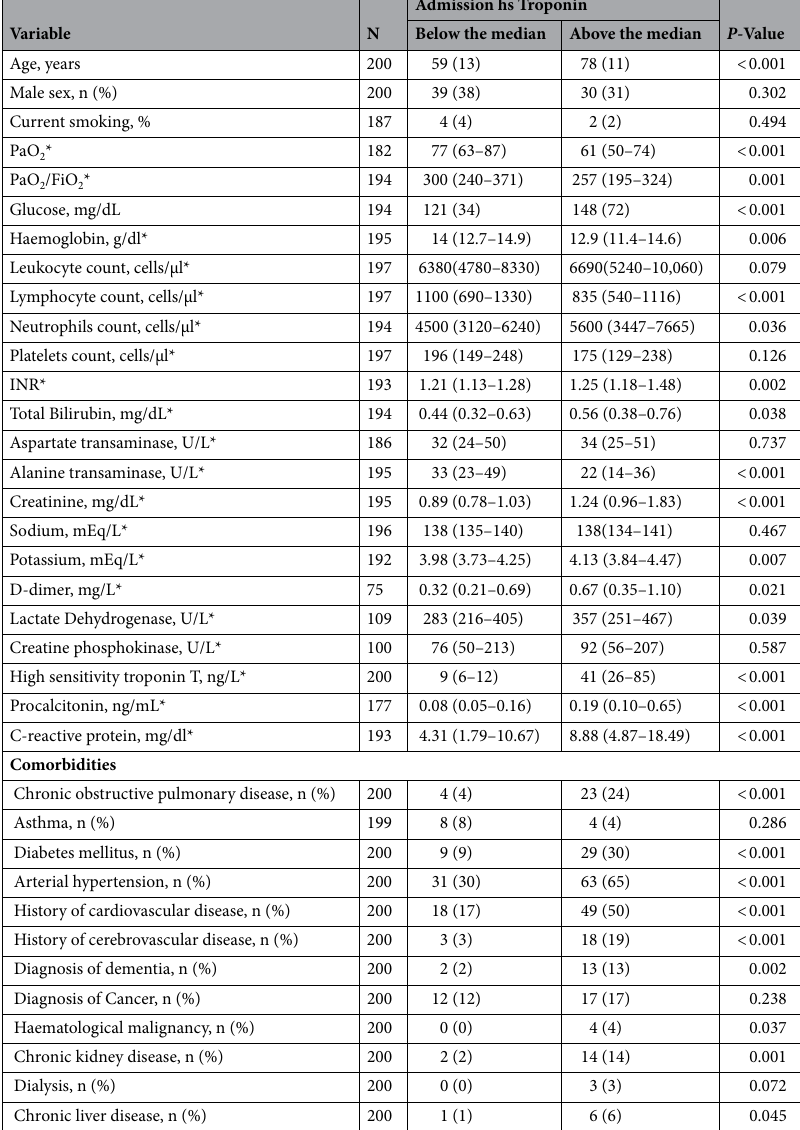
Table 5. Differences in the clinical characteristics of the population according to median levels of admission hsTnT. P -values are derived from independent samples Student’s T Test or the Mann Whitney test for continuous variables and the chi squared test for categorical variables; *Median and interquartile range.